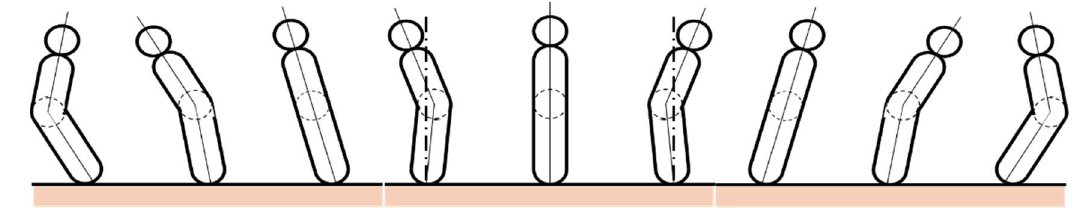
Figure 1. Combination of Inclination Sway and Bending Sway; LR, LL, LS, SL, SS, SR, RS, RR, and RL. (Back view).